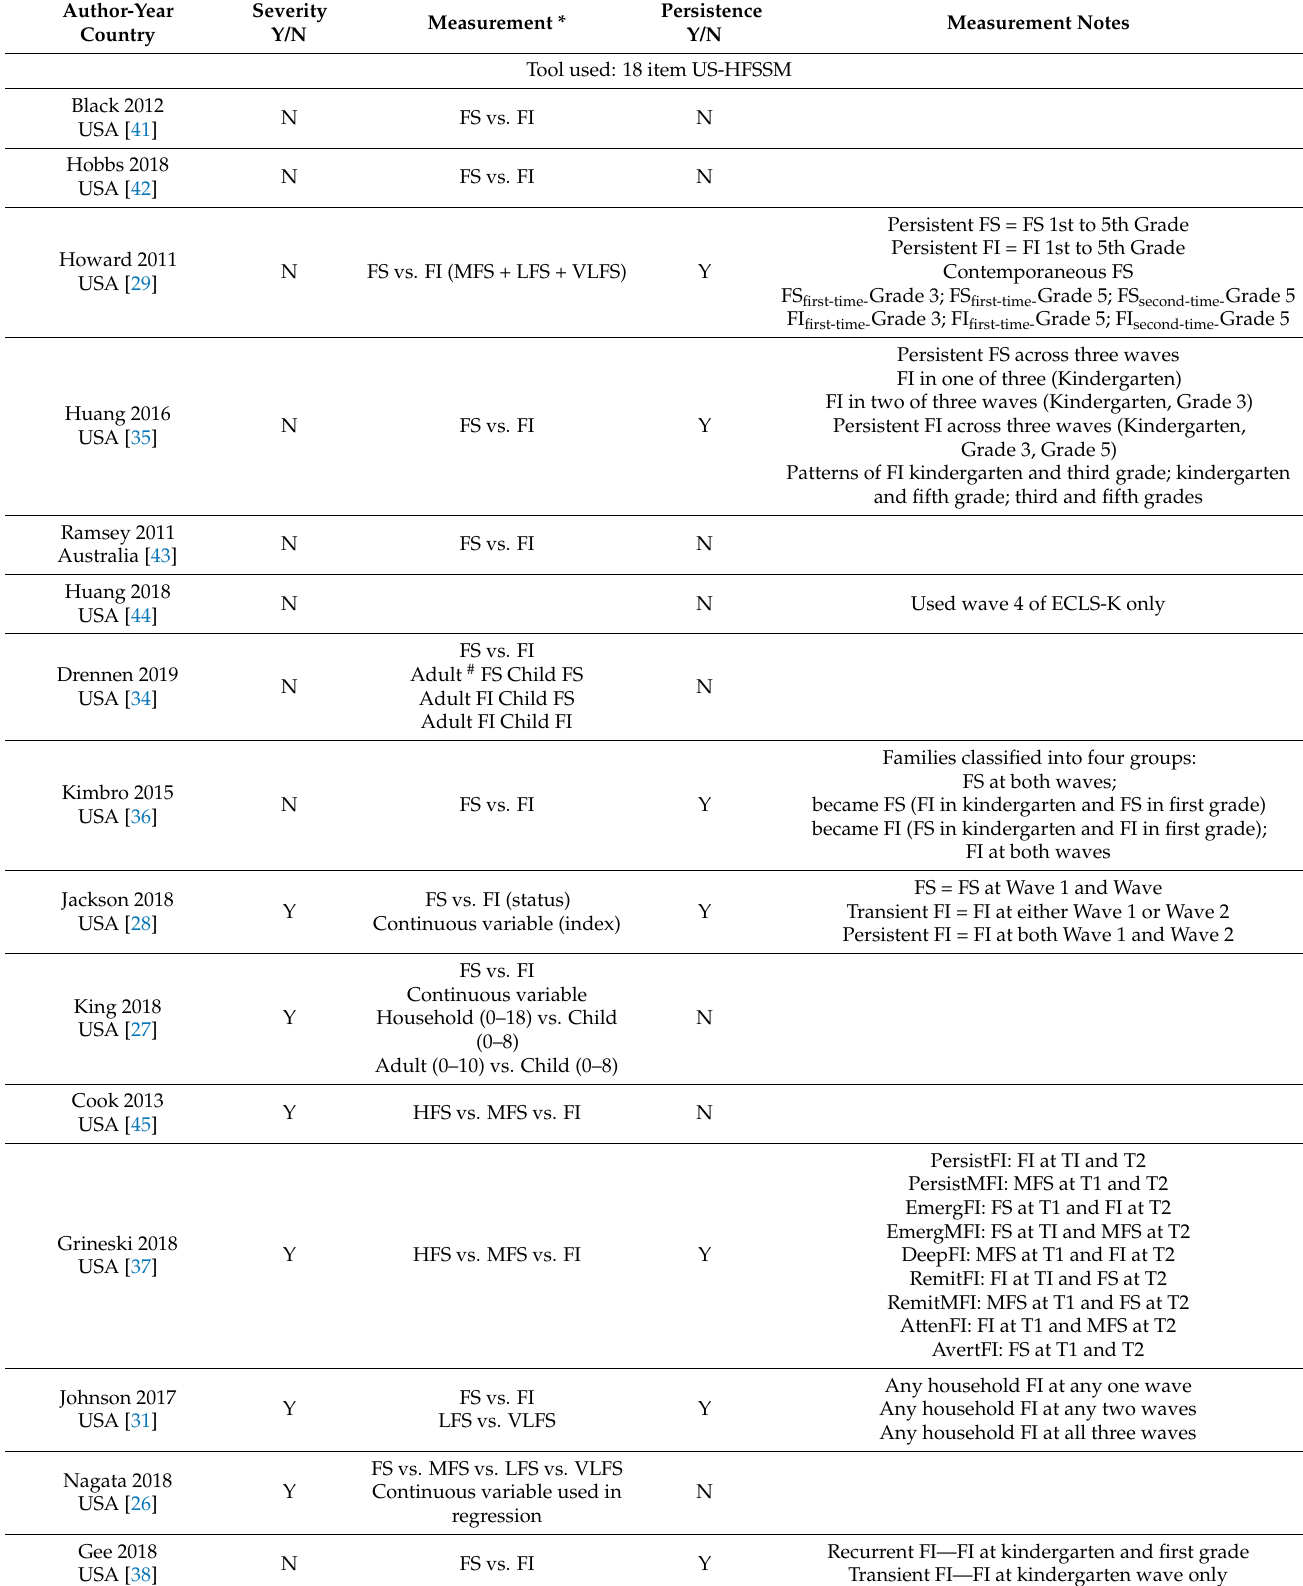
Table 2. Food security measurement tools and characteristics used in identified